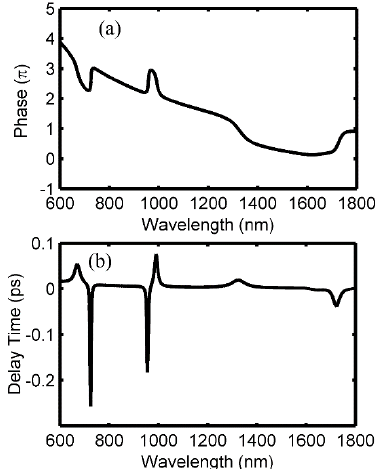
Figure 3. ( a ) Phase response with respect to the wavelength, ( b ) Group delays calculated from phase response.